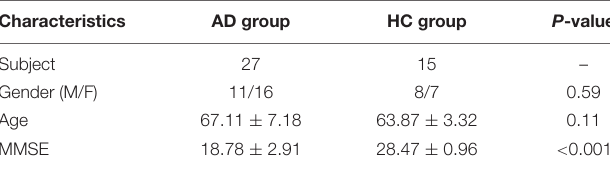
Table 1 . The exclusion criteria for the AD group were as follows: (1) It may be dementia other than AD, such as vascular dementia, paralytic dementia, dementia syndrome caused by other brain or physical diseases, etc. (2) Those who are unable to cooperate with severely impaired speech expression, comprehension, severe visual and hearing impairment, and other reasons. The exclusion criteria for the AD and HCs group were as follows: (1) MRI contraindications. (2) A history of substance